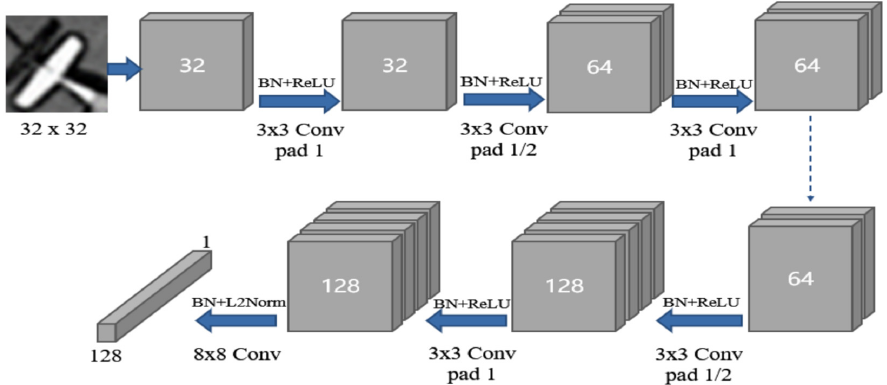
HardNet introduces a new loss for metric learning based on the CNN structure of L2-Net [32], and has been trained on Brown and HPatches datasets. When designing the network, every convolutional layer is followed by batch normalization (BN) and the ac- tivation function ReLU, except for the last one. Dropout regularization strategy is used before the last convolutional layer. The specific network structure is shown in Figure 6.